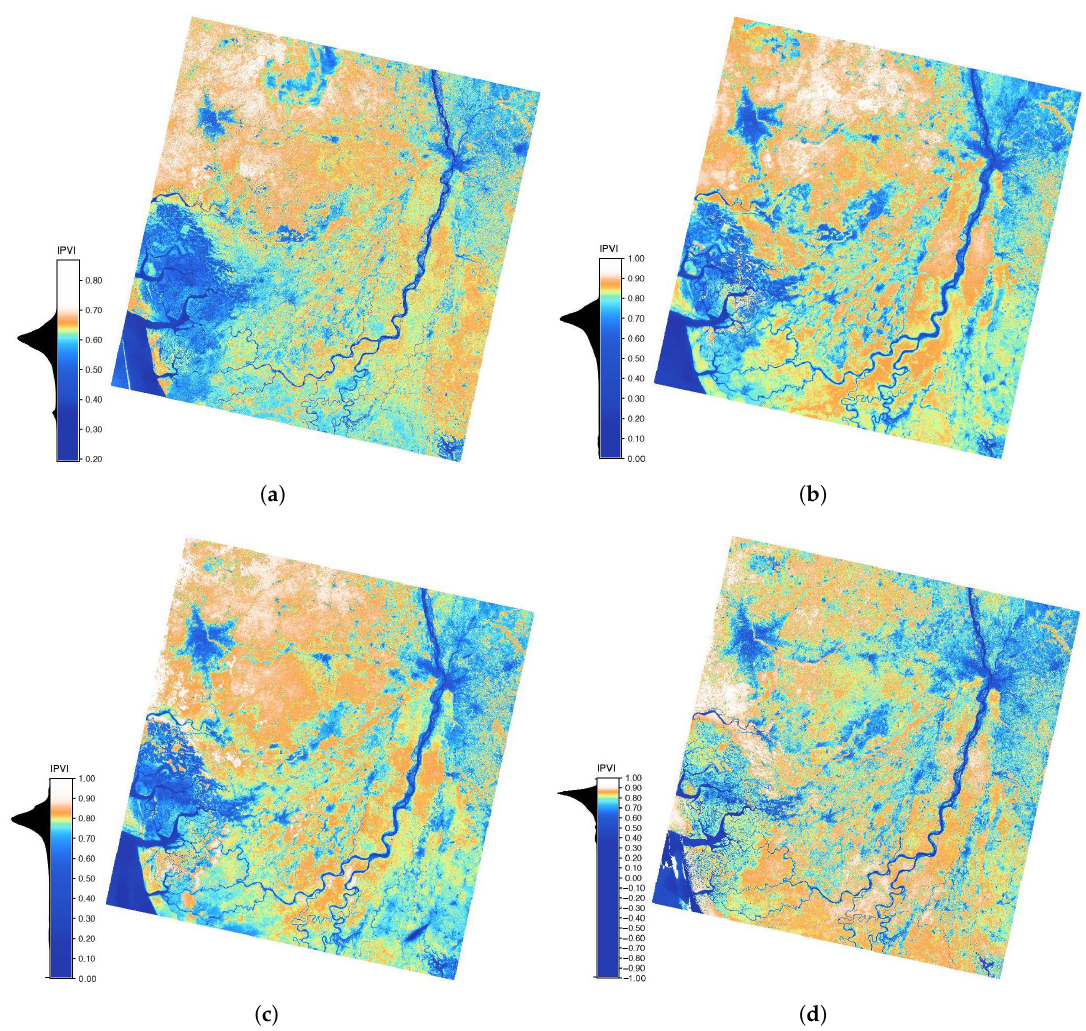
Figure 11. IPVI computed from the Landsat 8-9 OLI/TIRS images of Niger River Delta for four years: ( a ) 2013, ( b ) 2015 ( c ) 2021, ( d )